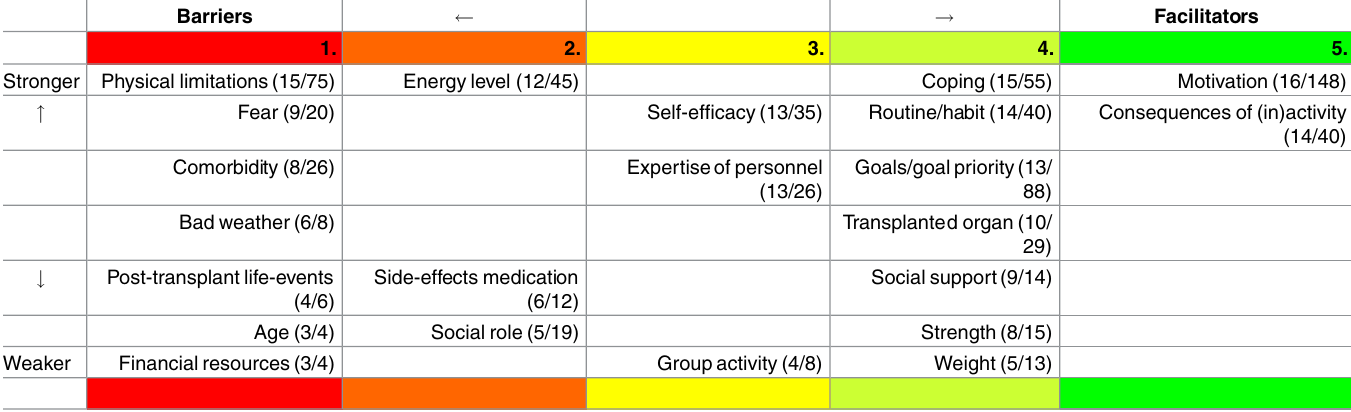
Table 2. Overviewdistribution barriers to and facilitators of physicalactivityand solidityin the data.